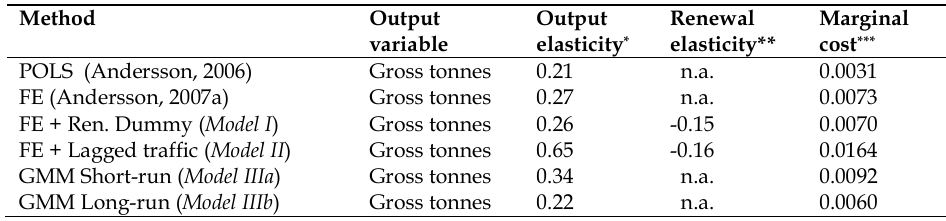
Table 6. Maintenance costs - main results